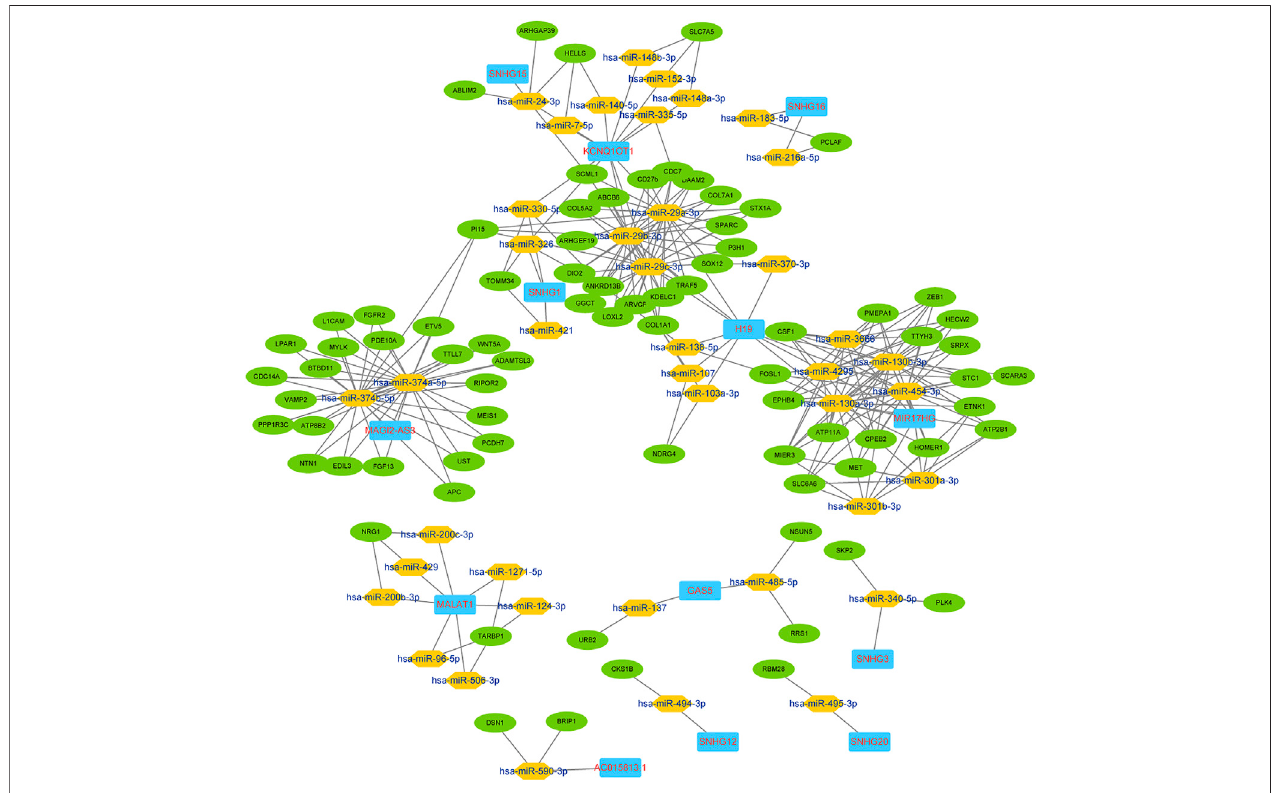
FIGURE 2 | lncRNA-miRNA-mRNA ceRNA preliminary